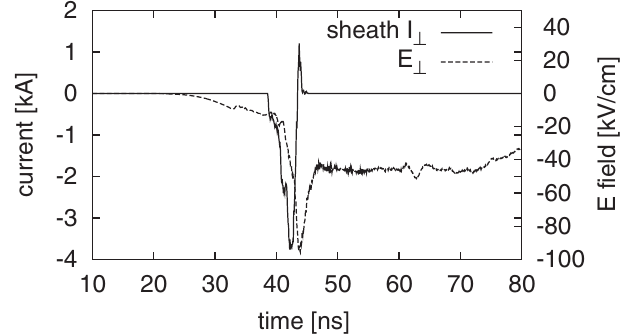
FIG. 9. Transverse current and field in IVA cell 4 for a 7.7 ns between the firings of cells 3 and 4. The values are measured at x ¼ 25 cm and y ¼ 0 in Fig. 8.